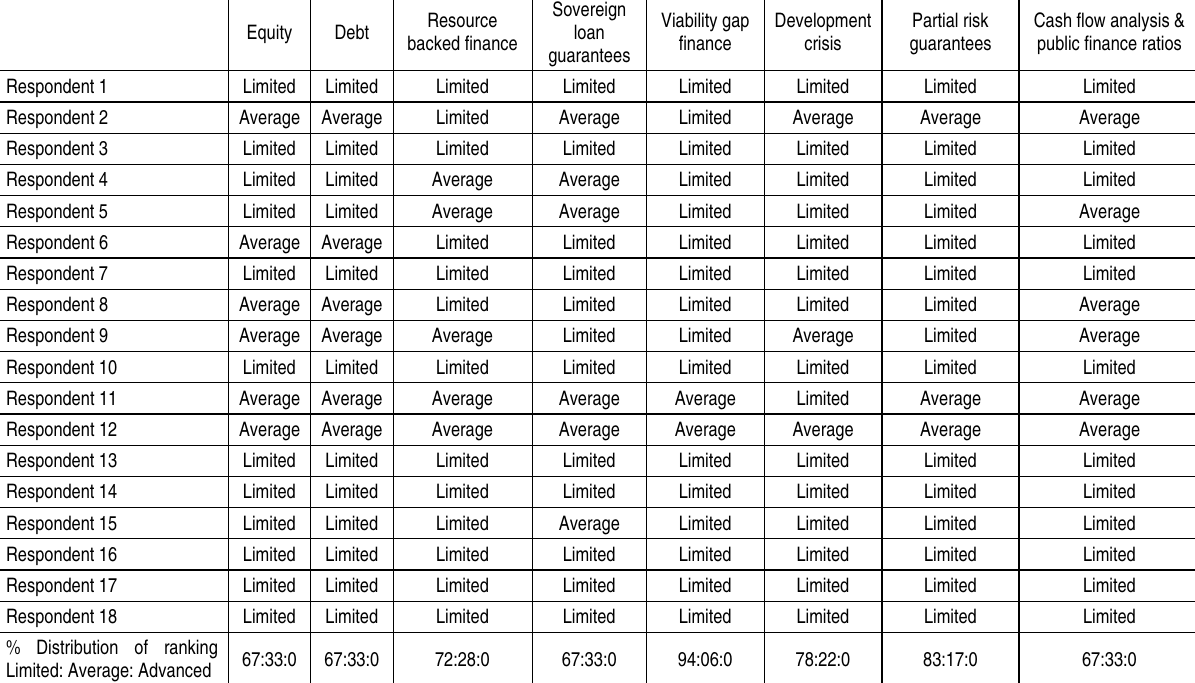
Table 1. Rating of working knowledge of instruments, products and services